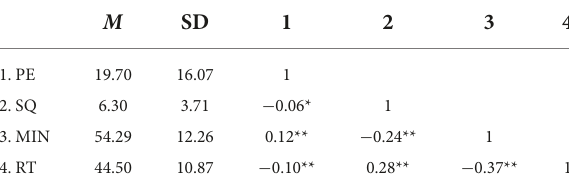
TABLE 1 Descriptive statistics of the main variables and their correlation